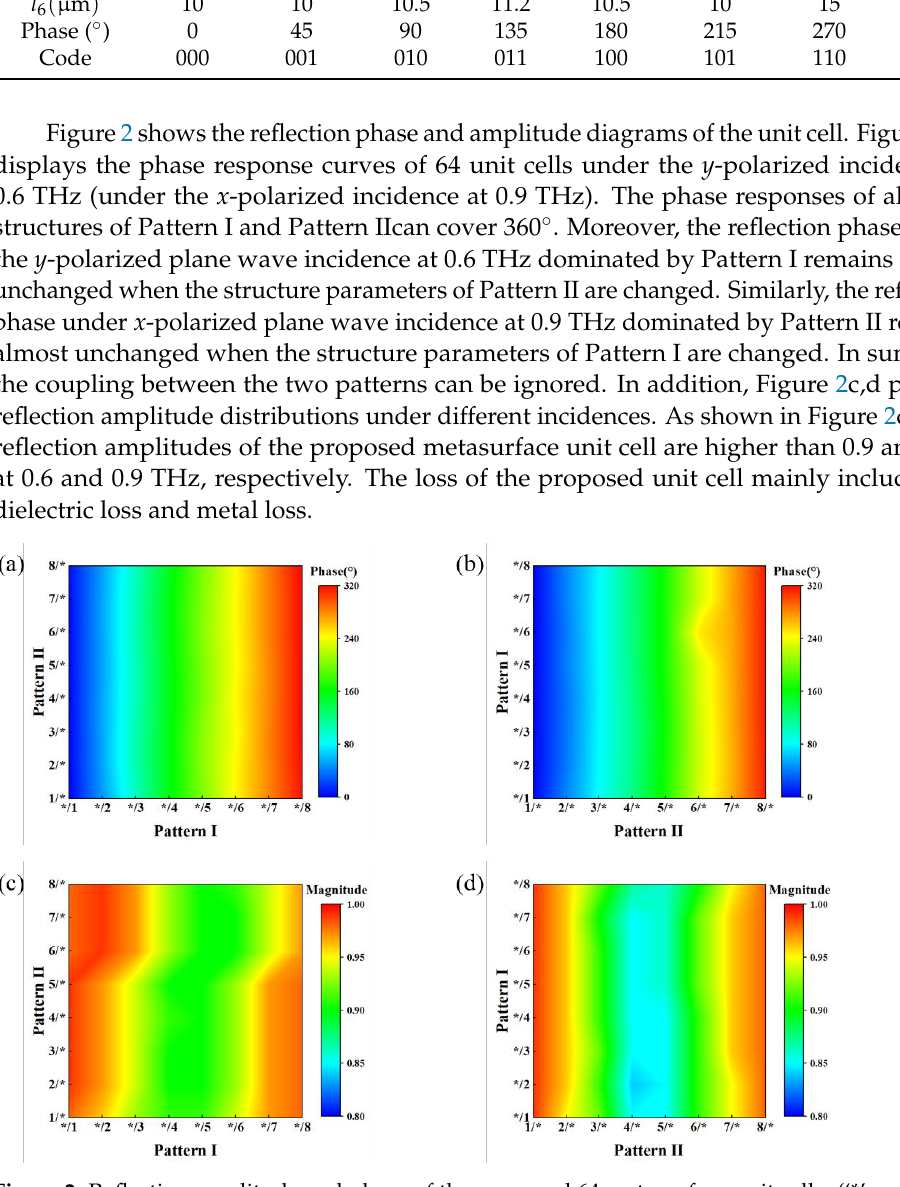
Figure 2. Reflection amplitude and phase of the proposed 64 metasurface unit cells. (‘*’ represents any integer from 1 to 8.) ( a , c ) are reflection phase and amplitude distribution with y -polarized plane wave incidence at 0.6 THz. ( b , d ) are reflection phase and amplitude distribution with x -polarized plane wave incidence at 0.9 THz.